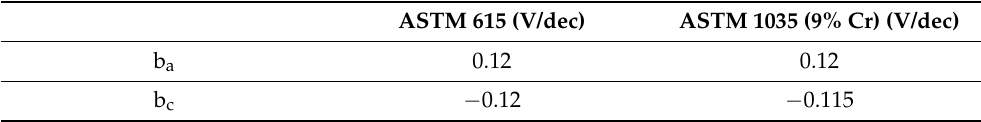
Figure 5. Cyclic polarization curves obtained for carbon steel 615 and low alloy steel 9% Cr. Table 2. Tafel slopes for 615 and 9% Cr steel